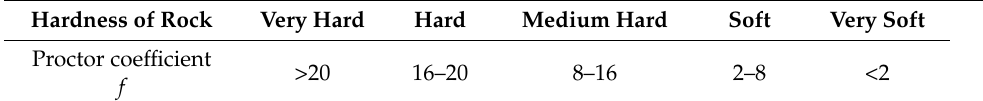
Table 4. Rock hardness classification.